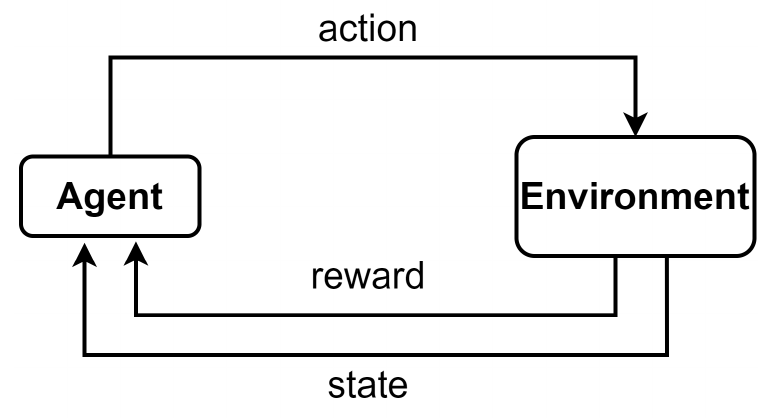
Figure 1. The basic framework of reinforcement